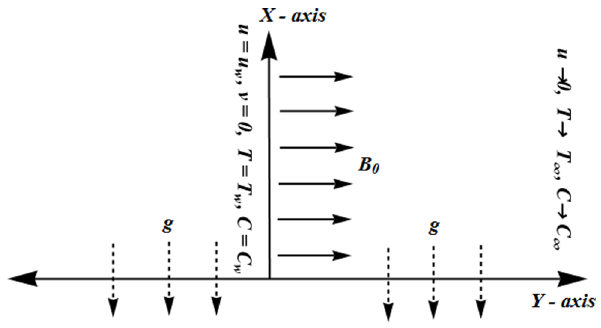
Figure 1. Physical model.